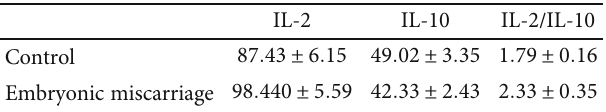
Bacterial density was divided into four levels according to the number of bacteria: grade 1 (+) as 1 – 3 kinds of bacterium; grade 2 (++) as 4 – 6 kinds of bacterium; grade 3 (+++) as 7 – 10 kinds of bacterium; and grade 4 (+++ +) as more than 10 kinds of bacterium. The metered data is recorded in N (%), p < 0 : 001 . Table 4: IL-2 and IL-10 levels and the ratio of IL-2 :IL-10 (units: pg/ml). IL-2